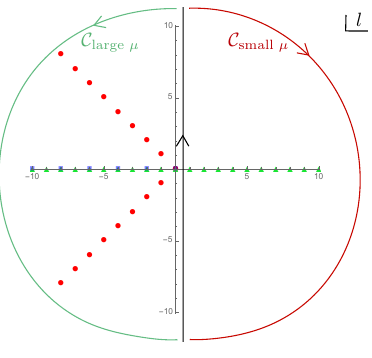
Figure 3 . The integration contour in the complex l -plane and the poles of the integrand in (4.14) from the Gamma functions both in (4.13) and from Z (0) from (4.16). The (cid:12)gure is plotted for l m 1 = 0 ; m 2 = 1 = 2. As m 2 increases, the complex poles from Z (0) (red) form a wider angle in the l left half-plane. The real poles from Z (0) are plotted in blue, whereas the green poles arise from the l gamma functions in